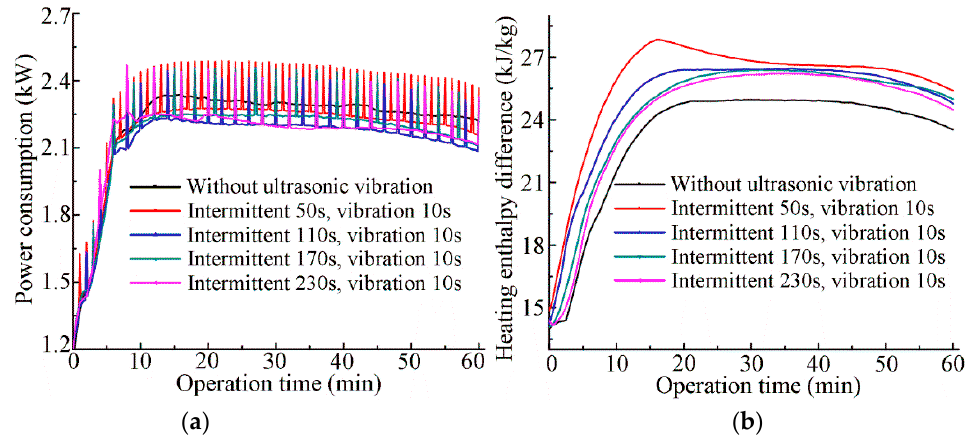
Figure 17. Energy consumption and heating capacity in different intermittent ultrasonic vibration modes. ( a ) Power consumption; ( b ) heat-supply enthalpy difference.